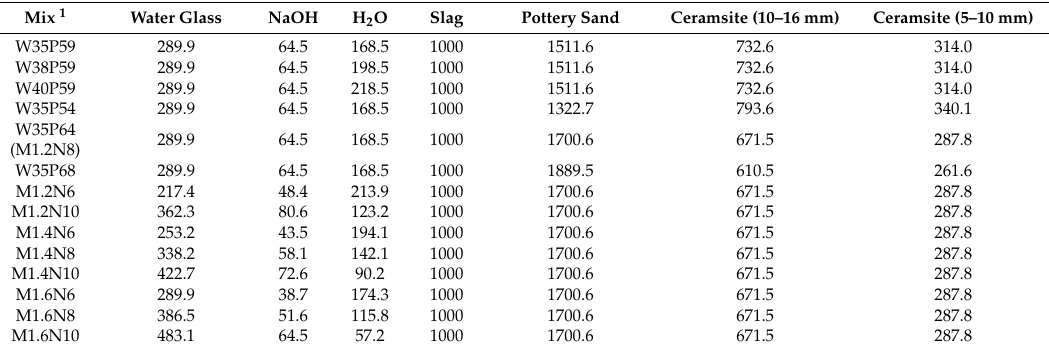
Table 3. Mix proportions used in this study (g).